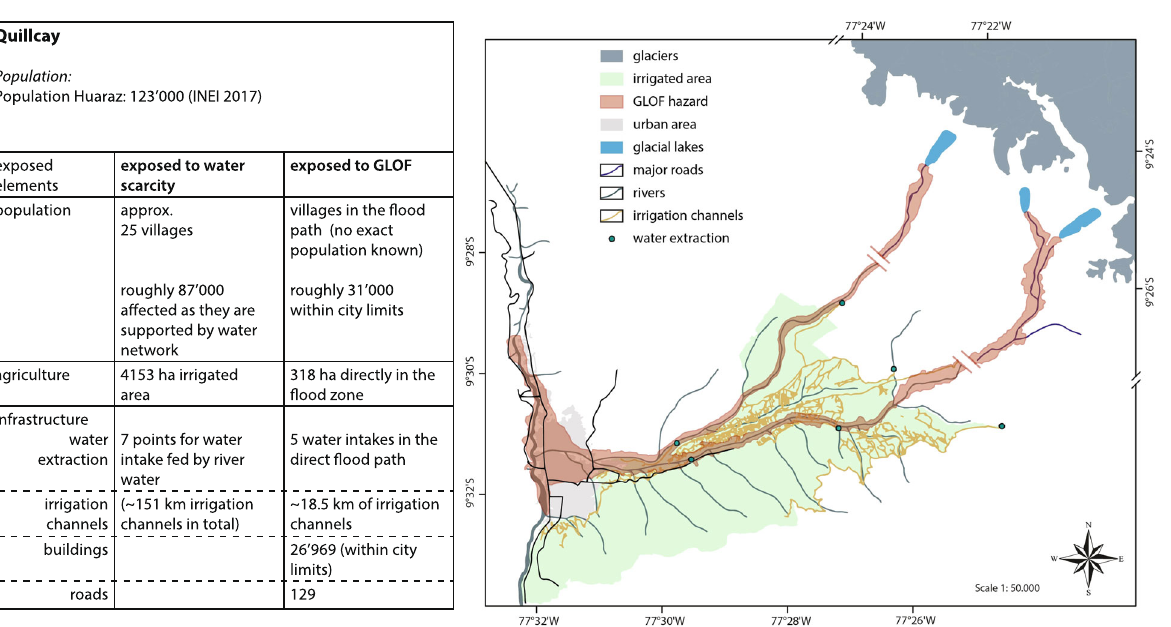
Fig. 3 GLOF exposure for the Quillcay and city of Huaraz